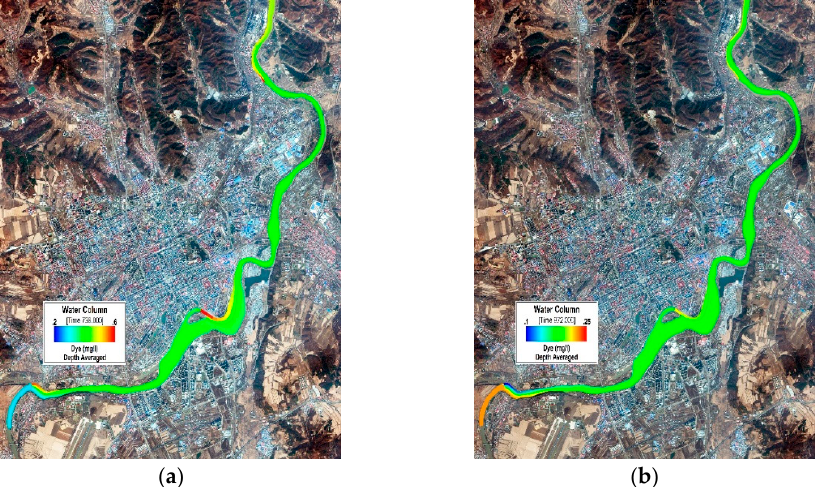
Figure 9. NH 3 N concentration distribution in the Mudan River trunk stream (urban sections).